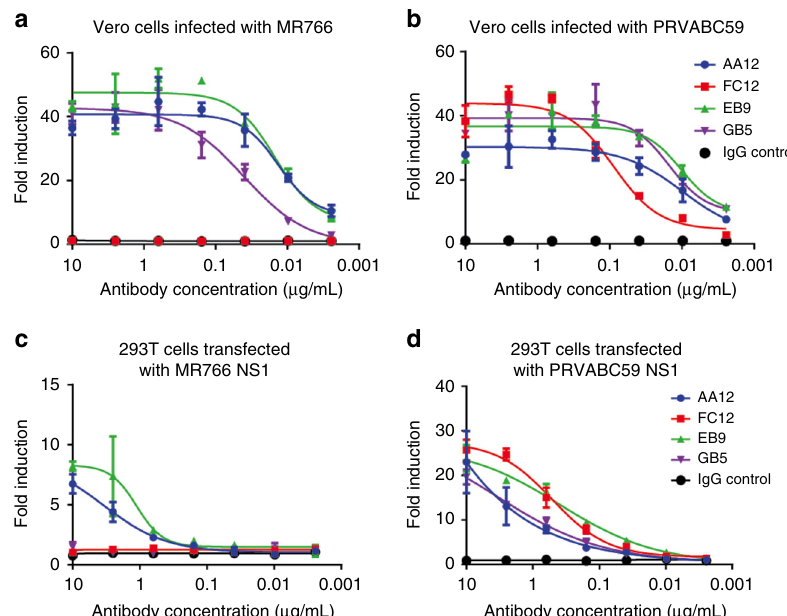
Fig. 2 NS1-speci fi c antibodies activate Fc-FcR effector functions in vitro. To examine the ability of NS1-speci fi c antibodies to activate Fc-FcR mediated effector functions, a , b Vero cells were infected with MR766 and PRVABC59 Zika viruses or c , d HEK 293T cells were transfected with NS1 from MR766 and PRVABC59 Zika viruses. Infected Vero cells or transfected HEK 293T cells were used as targets for measuring antibody-mediated effector functions with a genetically modi fi ed Jurkat cell line expressing the human FcR γ IIIa with an inducible luciferase reporter gene. Fold induction was measured in relative light units and calculated by subtracting background signal from wells without effector cells then dividing wells with antibody by wells with no antibody added. All mAbs were tested at a starting concentration of 10 μ g per mL and were serially diluted four-fold. Assays were performed twice as technical duplicates and one of two replicates is shown. A non-linear regression best- fi t curve was generated for each dataset using GraphPad Prism 5. Error